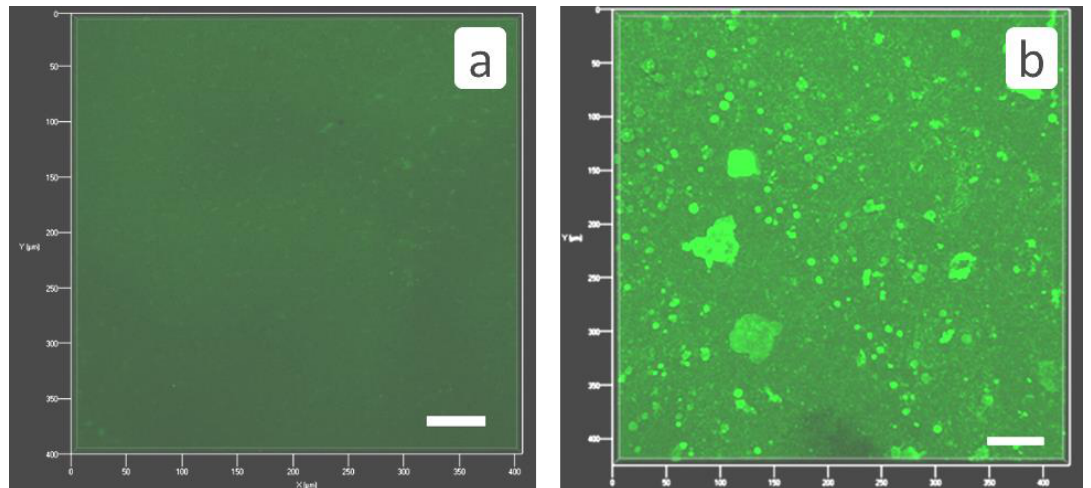
Figure 8. 3D fluorescent images of virgin untreated membrane ( a ); and of membrane surface after RO treatment in the presence of HEDP-F ( b ). HEDP-F fluorescence—green pseudo-color, Scale marker corresponds to 50 μm.